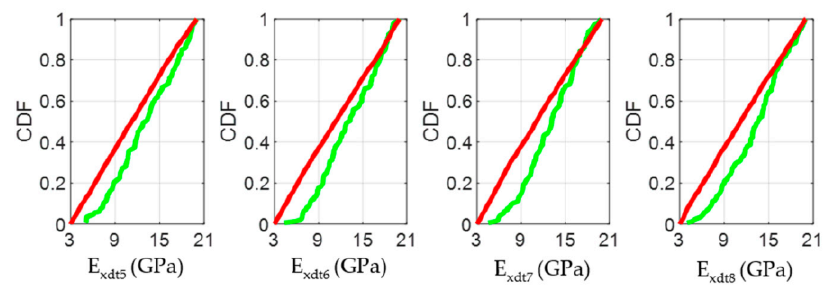
Figure 16. Cumulative Distributions Functions (CDFs) of the four input factors located in the central third of the timber board # 19 ( E xdt in zones 5 to 8) for the output metric (Y function). The green and red curves represent the sets B (behavioral) and NB (non-behavioral), respectively.